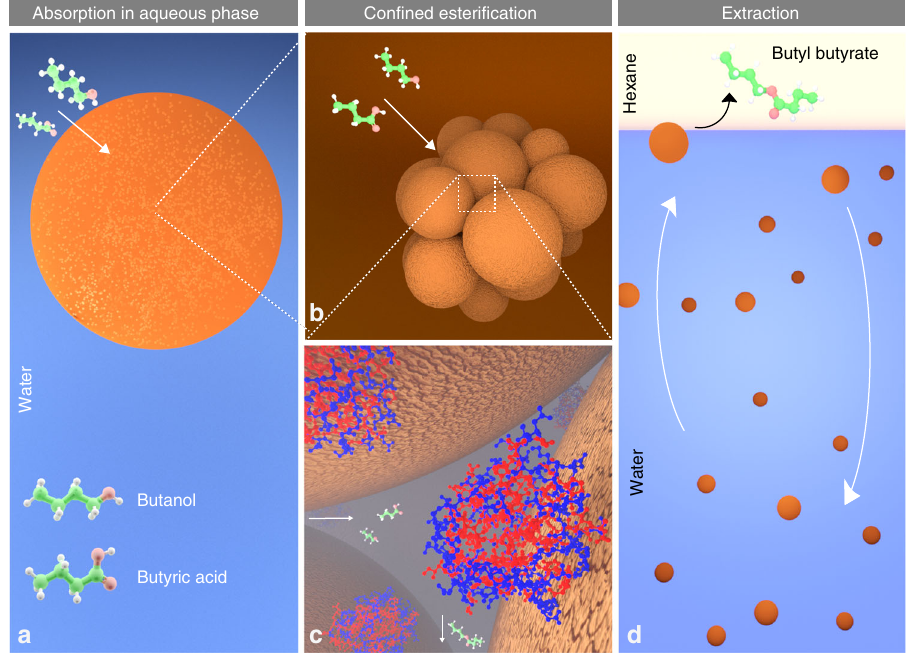
Fig. 4 Schematic mechanism of the compartmentalized butyl butyrate synthesis. a The reagents diffuse from water into an alginate bead containing spatially con fi ned enzymes. b Diffusion of the reagents into the biocatalytic clusters consisting of enzymes adsorbed on cationic lignin nanospheres. c Ester synthesis occurs in the inner space con fi ned by the c-CLPs. Hydrolases act as gatekeepers that enhance the selective permeation of butanol and butyric acid. Hydrophobic residues are shown in red color for the HiC molecules 46 . d Diffusion of the produced butyl butyrate into the organic phase is driven by agitation that sequentially brings the biocatalyst beads to the solvent nanospheres serve as gatekeepers for the organic reactants. The The schematic mechanism in Fig. 4 visualizes the esteri fi cation ability of the beads to resist swelling in water (Supplementary reaction catalyzed by spatially con fi ned biocatalysts. First, butanol Fig. 6) means that laborious water removal by molecular sieves 35 , and butyric acid diffuse into the alginate bead containing immobilized enzymes. Enzymes con fi ned between adjacent distillation 13 , or membrane reactors 36 becomes obsolete, while